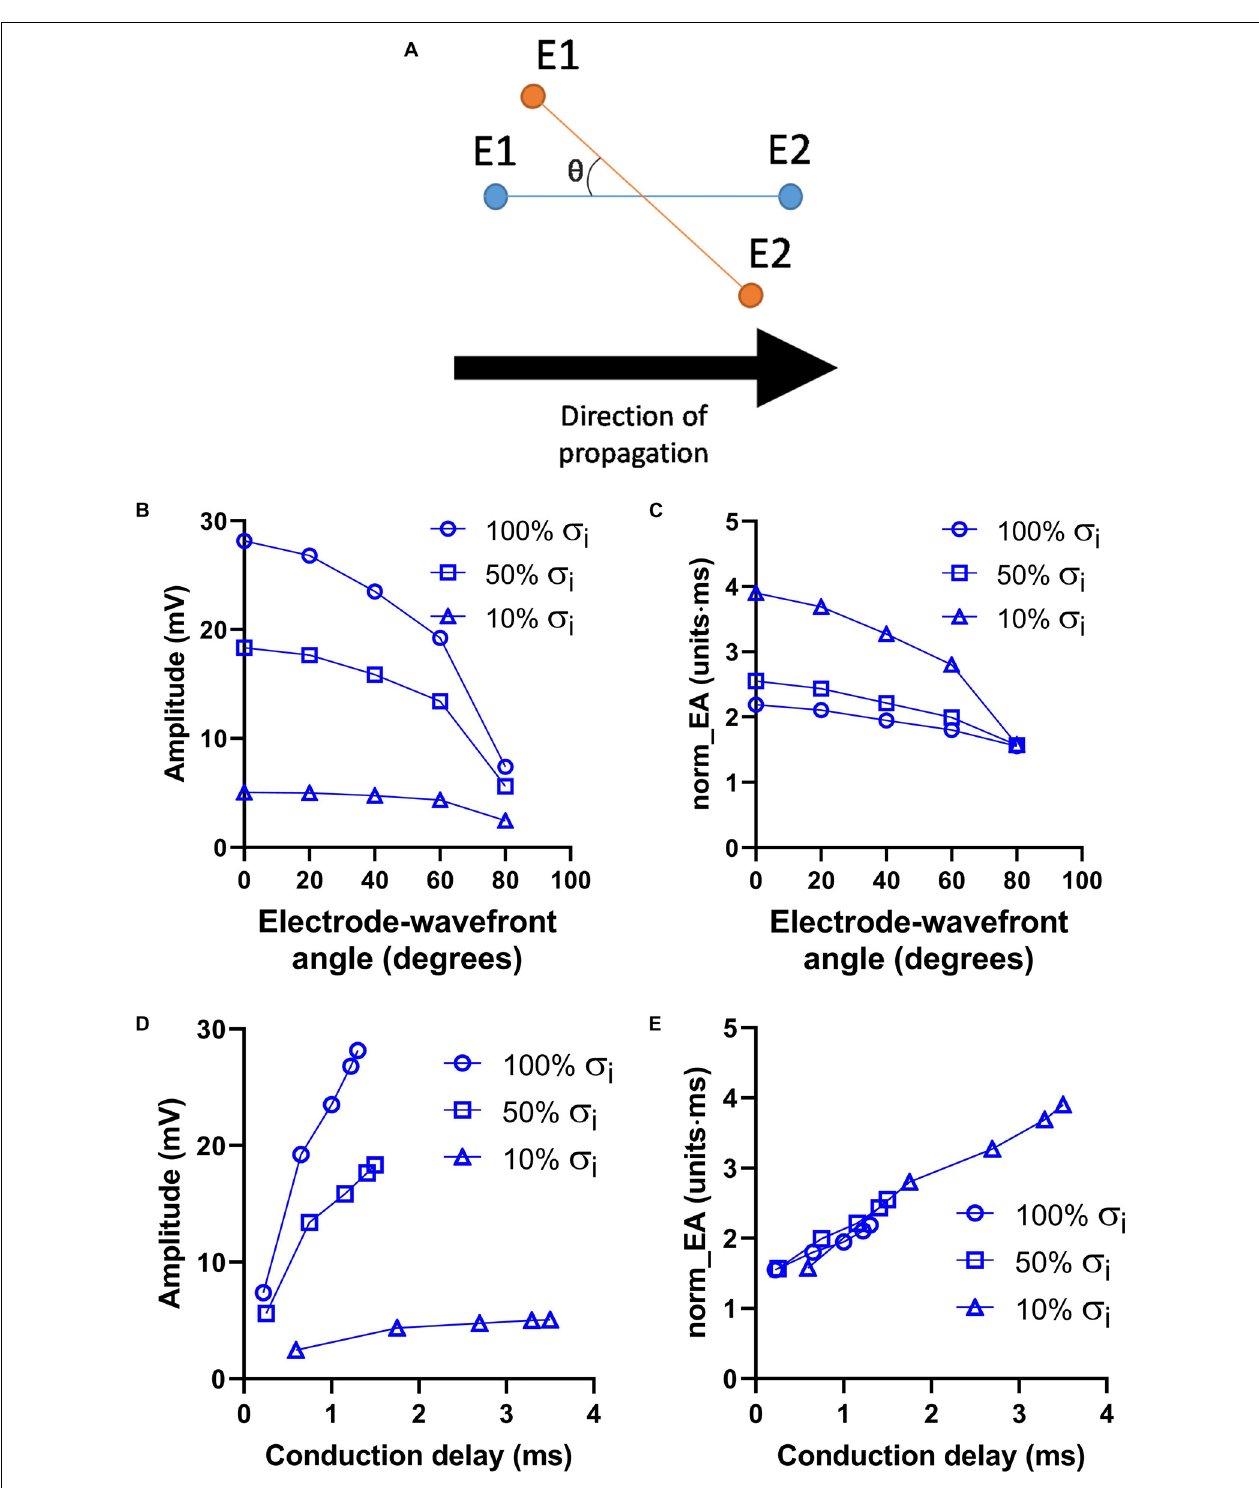
FIGURE 5 | Influence of electrode orientation on bipolar electrogram morphology in a model of a propagating mouse action potential. Data showing the impact of altering the orientation of the recording electrodes relative to the direction of propagation of the activation wavefront (electrode-wavefront angle) on bipolar electrogram morphology. (A) Representative diagram showing change in electrode-wavefront angle. (B,C) Data showing the change in bipolar electrogram amplitude and normalized electrogram area (norm_EA) as a function of the electrode-wavefront angle. 0 ◦ represents the initial model conditions. Data are shown for varying levels of intracellular conductivity ( σ i ). (D,E) The same data plotted as a function of the local conduction delay between the recording electrodes.